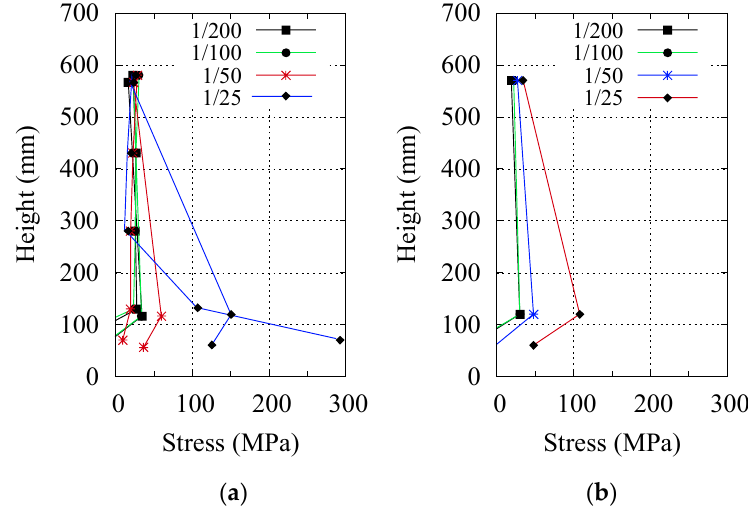
Figure 12. Stress distributions of confinement reinforcements: ( a ) BSH; ( b ) BS.